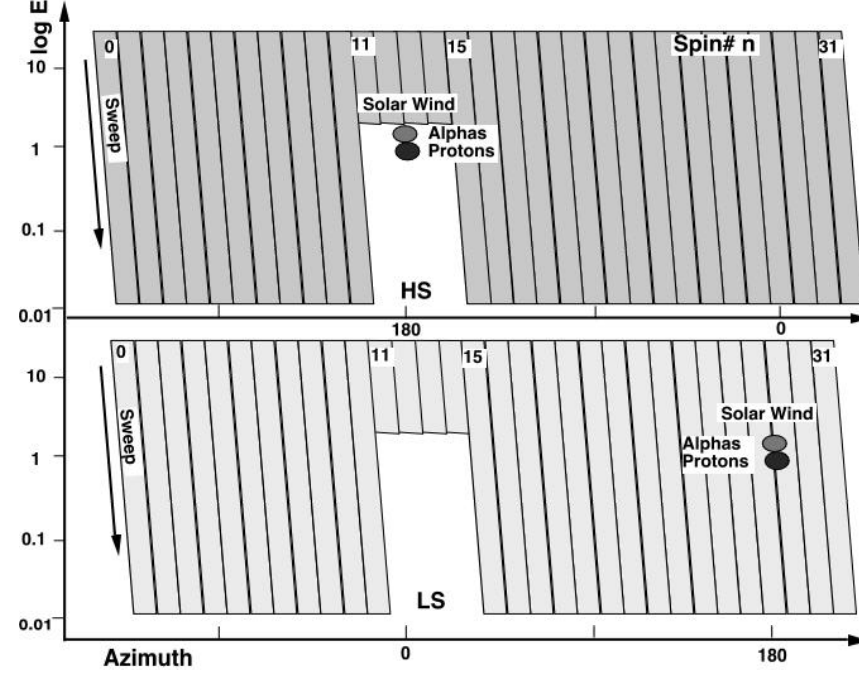
Fig. 12. Energy sweeping scheme of CODIF in the solar wind. The sweep is shown in the log E versus the azimuthal angle for the high- sensitivity section (upper panel) and low-sensitivity section (lower panel), starting at the high energy end. When looking into the solar wind, the sweep stops above the alpha particles for the high-sensitivity section but the sweep does not stop for the alpha particles and the protons for the low-sensitivity